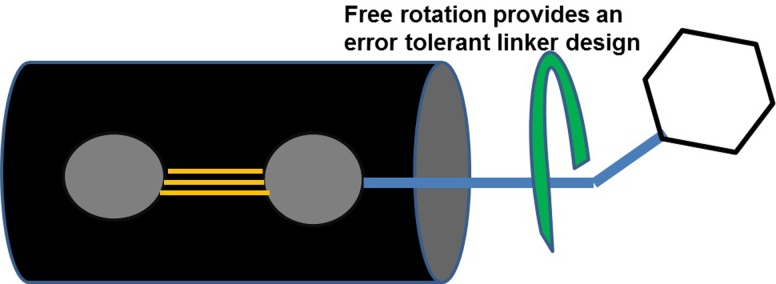
Direct single bond linkage to a triple bond enables penalty-free complete 360° dihedral rotation.A group terminally attached to an acetylene linker can freely align to match the contours of PCSK9 in this region and simultaneously present polar hydrogen to PCSK9 D374 to pincer this key residue.